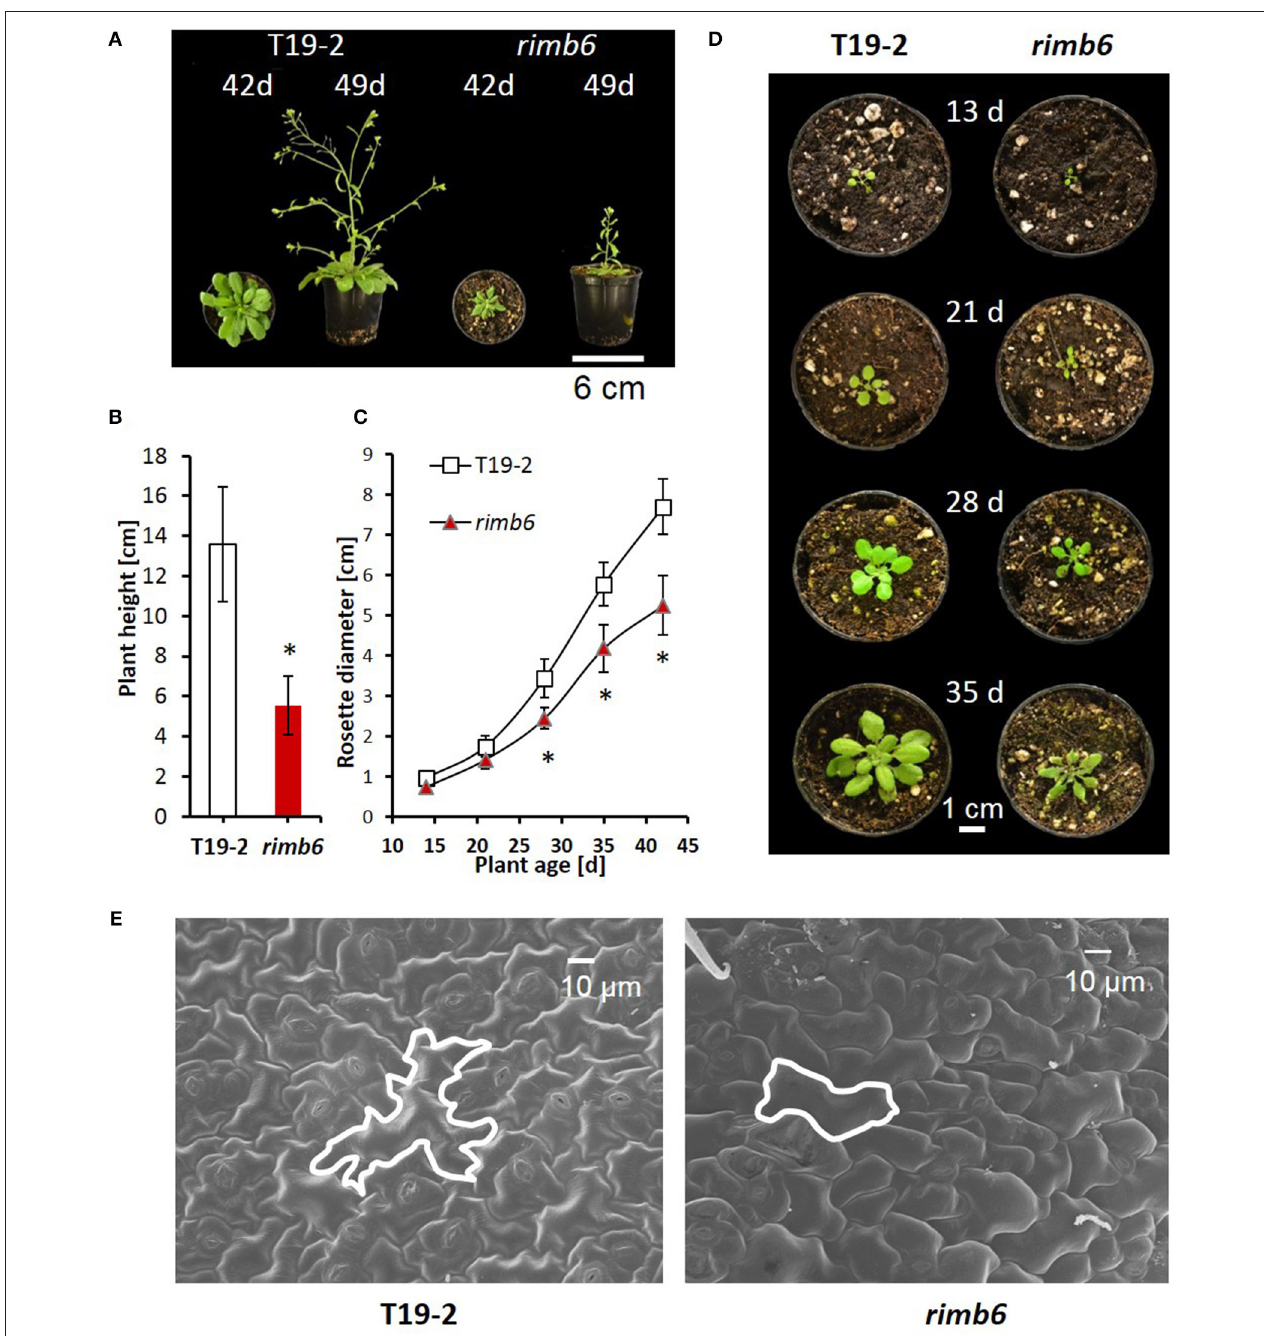
FIGURE 1 | Phenotypic characteristics of the redox signaling mutant rimb6 and its parental line T19-2. (A) Rosette morphology and shoot elongation of T19-2 and rimb6 after 42 d and 49 d. (B) Plant height of T19-2 and rimb6 (49 d) ( n = 10; * P < 0.01, pairwise t -test). (C) Rosette diameter in T19-2 and rimb6 ( n = 25; * P < 0.01, pairwise t -test). (D) Representative images of rimb6 and T19-2 during rosette development. (E) Laser scanning microscopy of upper leaf surfaces of rimb6 and the parental line T19-2. One exemplary cell is outlined using a white line.